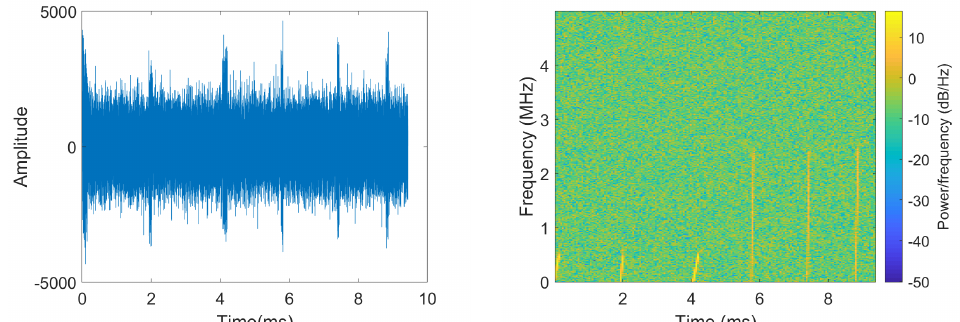
Figure 13. Time domain waveform and spectrogram of scattered wave baseband